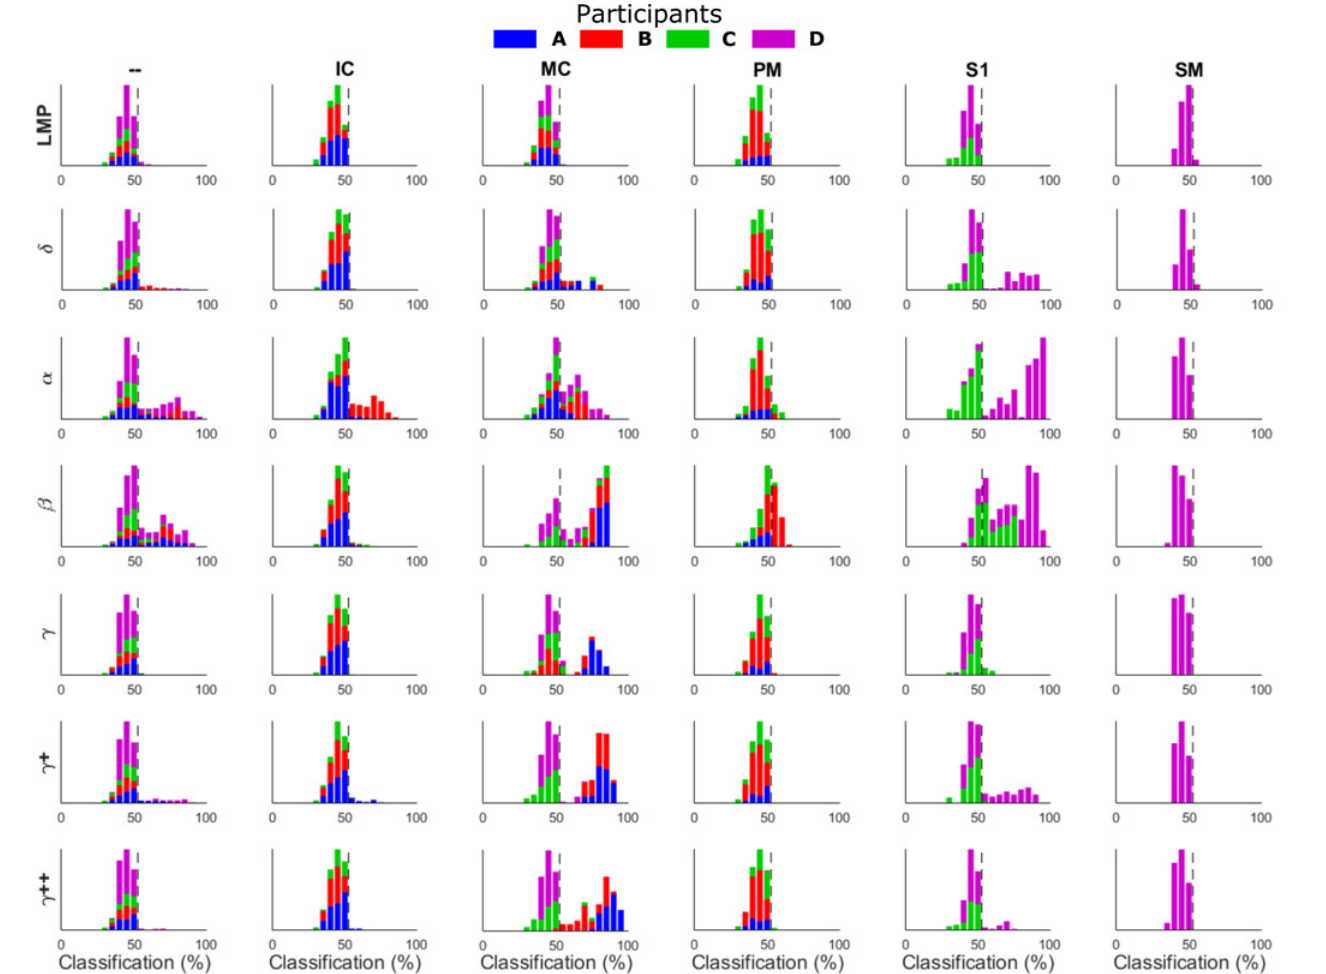
Fig 4. Classification density for single features. Histograms show the distribution of feature classification accuracies for force versus rest classification. These bar values represent the single feature classification accuracies across 10 repeats of the cross-validation and are organized by brain region ( — = White matter tracts, IC = Insular Cortex, MC = Motor Cortex, PM = Premotor Cortex, S1 = Primary Sensory Cortex, and SM = Supplementary Motor Area) and feature (LMP = Local Motor Potential, δ / θ = 0 – 6 Hz, α = 6 – 12 Hz, β = 12-30Hz, γ = 30 – 50 Hz, γ + = 70 – 110 Hz, γ ++ = 130 – 170 Hz). Colors correspond to each participant (blue = A, red = B, green = C, and purple = D) with pinch and power grasp configurations combined. Dotted line (52.67%) shows the high end of the 95% confidence interval for chance classification. All participants had motor cortical features that could be used for discrimination of force versus rest in contrast to other brain regions which were more participant